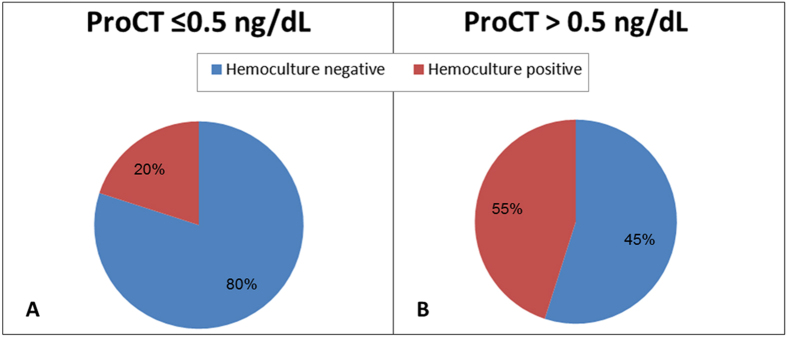
(A) Hemoculture stratification for PCT ≤0.5 ng/dL patients; (B) Hemoculture stratification for PCT >0.5 ng/dL patients.